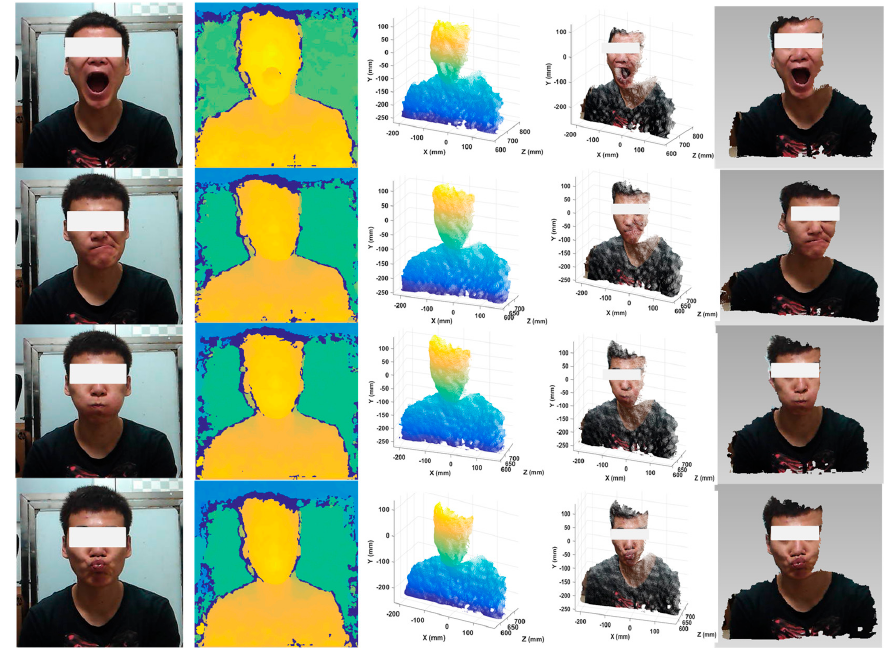
Figure 17. Reconstruction results of dynamic expressions using the proposed system. From left to right: original images, estimated depth maps, reconstructed point clouds, point clouds with textures, and 3D models (mosaic was added over the eyes to protect